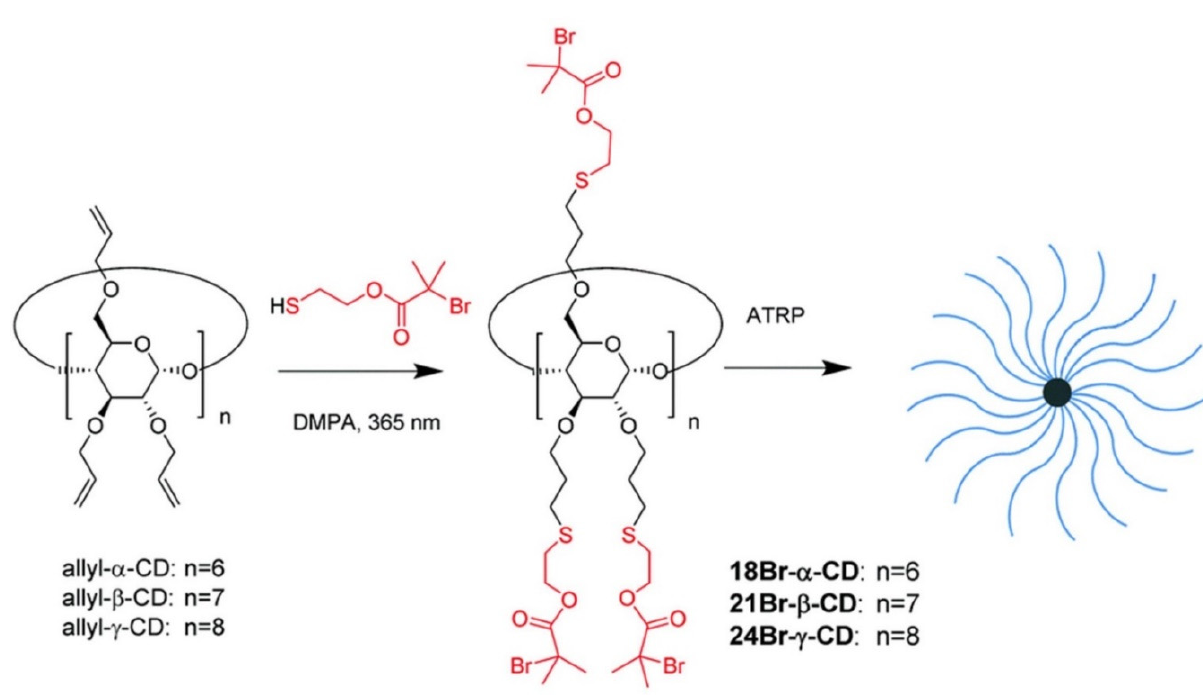
Figure 21. The synthetic route of multiarm star polymers from fully functionalized CD cores, as proposed by Yi. Reprinted with permission from [89]; published by The Royal Society of Chemistry, 2020.